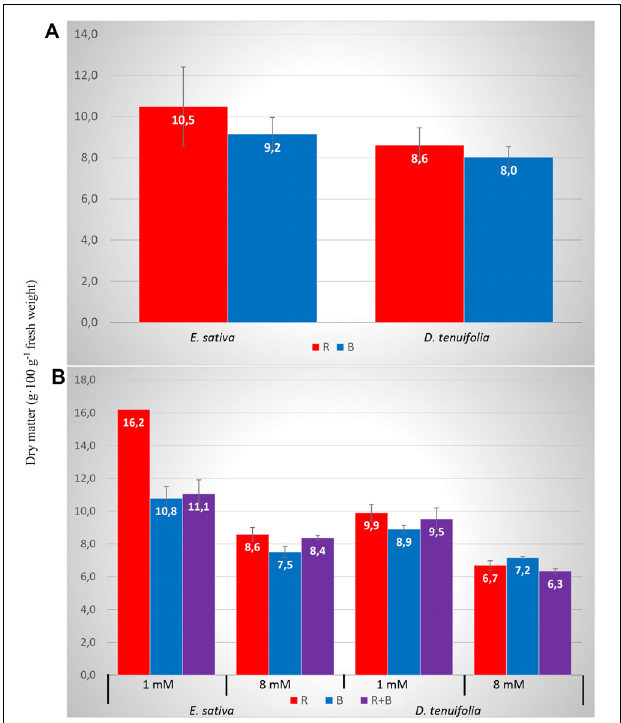
FIGURE 2 | Nitrates concentration of rocket leaves as influenced by interaction light x nitrogen level (A) and species × nitrogen level × light (B) . Vertical bars represent the standard error. S, species ( E. sativa and D. tenuifolia ); N, nitrogen level into the nutrient solution (1 and 8 mM); B, BLUE, peak at 460 nm; R, RED, peak at 660